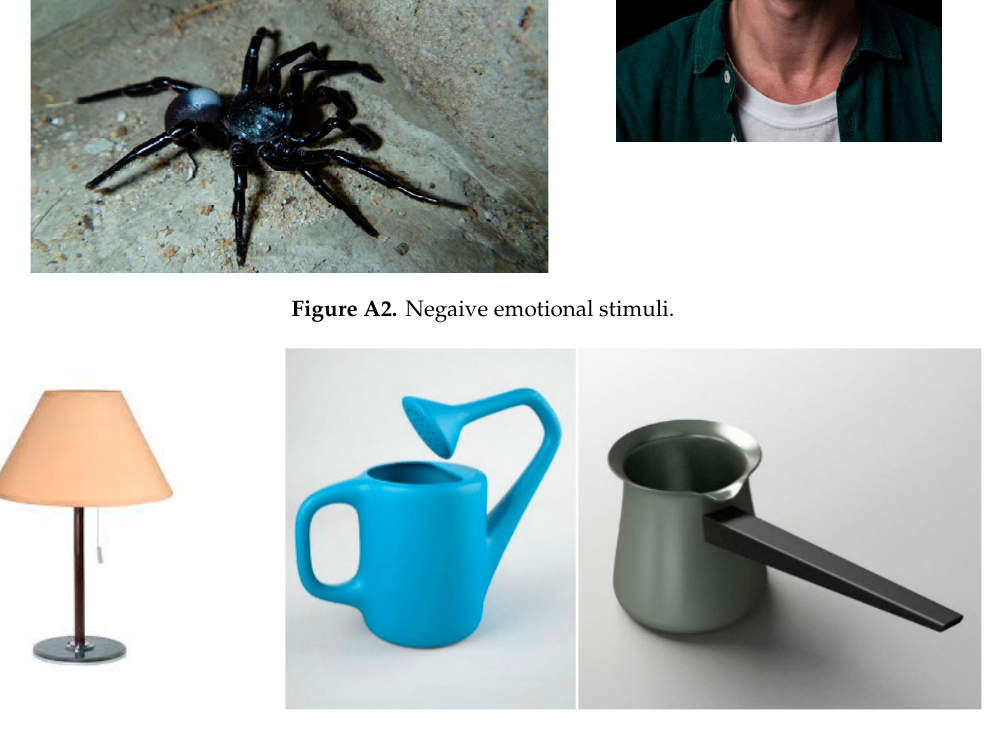
Figure A3. Neutral